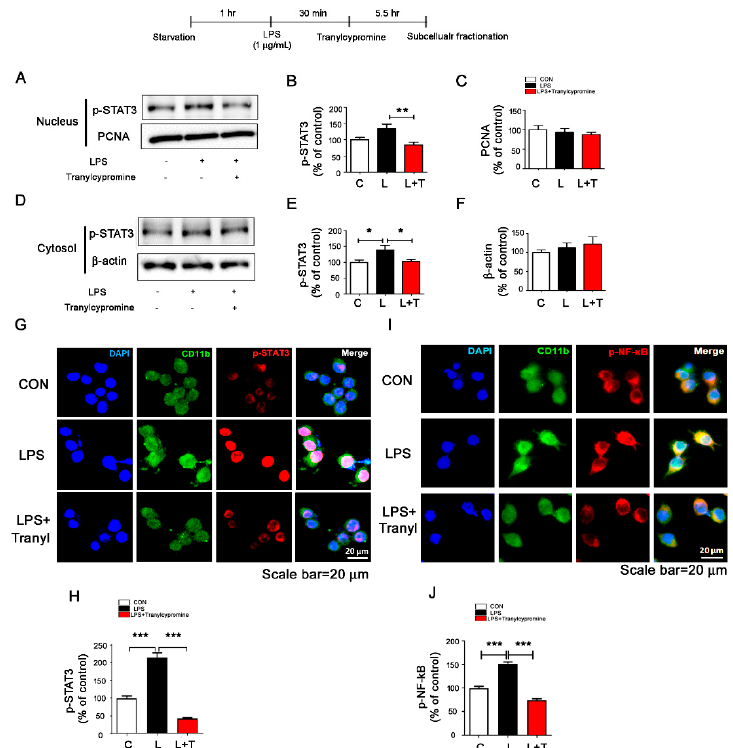
Figure 3. Tranylcypromine treatment downregulates LPS-mediated nuclear p-STAT3 levels in BV2 microglial cells. ( A – F ) BV2 microglial cells were pretreated with LPS (1 µ g / mL) or PBS for 30 min and treated with tranylcypromine (5 µ M) or vehicle (1% DMSO) for 5.5 h before subcellular fractionation (Nucleus and cytosol: n = 27 / group). ( G – J ) BV2 microglial cells were pretreated with LPS (1 µ g / mL) or PBS for 30 min and treated with tranylcypromine (5 µ M) or vehicle (1% DMSO) for 5.5 h. Immunocytochemistry was then performed with anti-CD11b and anti-p-STAT3 (s727) or anti-CD11b and anti-p-NF- κ B antibodies (p-STAT3: CON, n = 257; LPS, n = 260; LPS + tranylcypromine, n = 293; p-NF- κ B: CON, n = 240; LPS, n = 308; LPS + tranylcypromine, n = 325). * p < 0.05, ** p < 0.01, *** p < 0.001. CON and C, control; L, LPS; L + T, LPS +